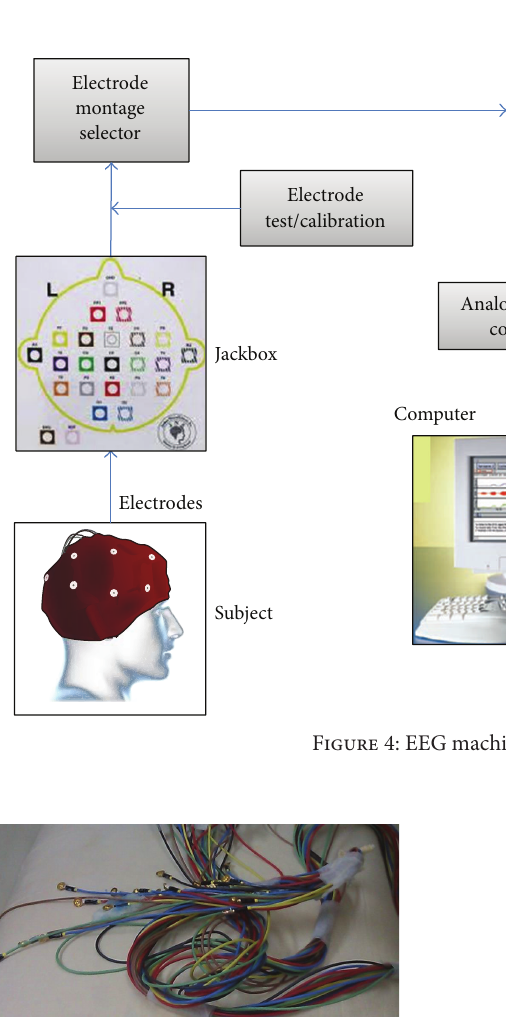
Figure 5: EEG cap